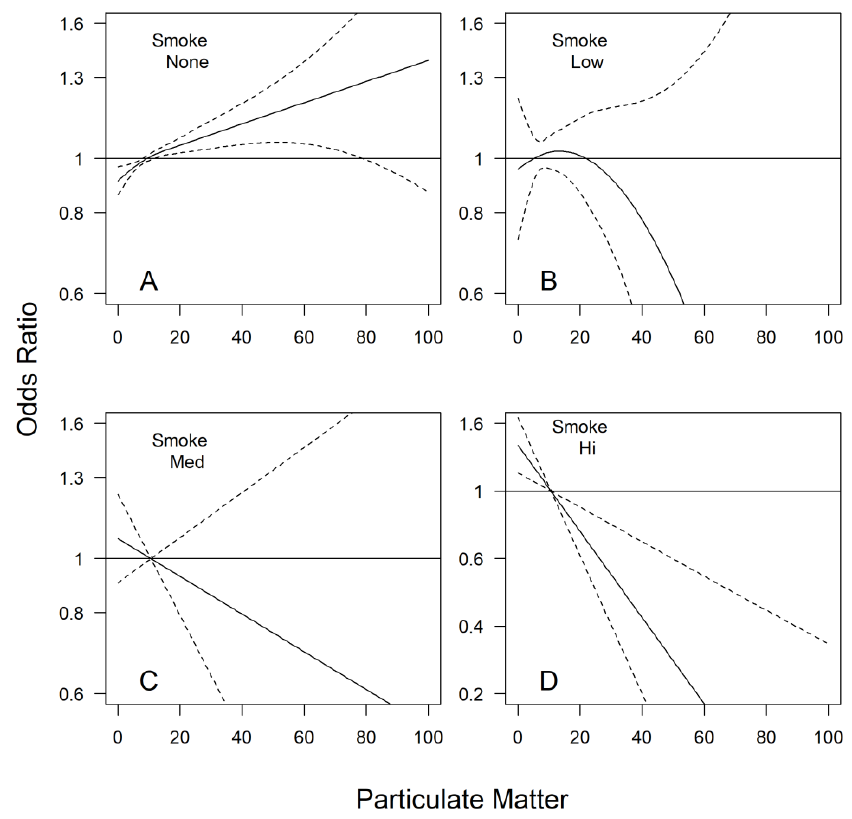
Figure 3. Estimated odds ratio of an emergency room visit, as a function of increasing fine particulate matter (PM 2.5 ) and smoke level, relative to the odds at the average PM 2.5 value of 10 µ g m − 3 at ( A ) no smoke, ( B ) low smoke level, ( C ) medium smoke level, and ( D ) high smoke level, above the site as detected by satellites.